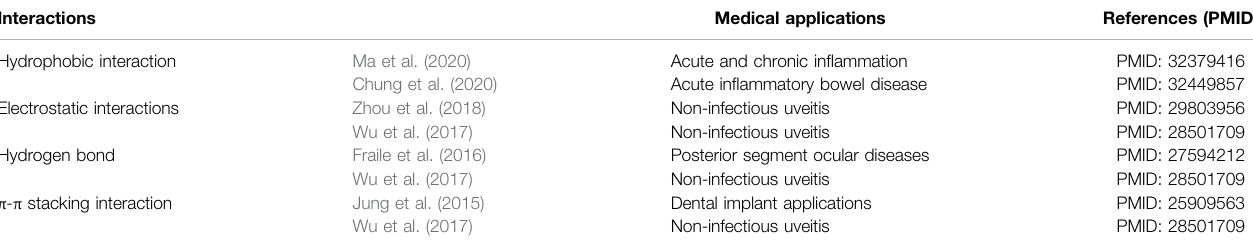
TABLE1 | Features and medical applications of different supramolecular interactions used for the delivery of steroids.